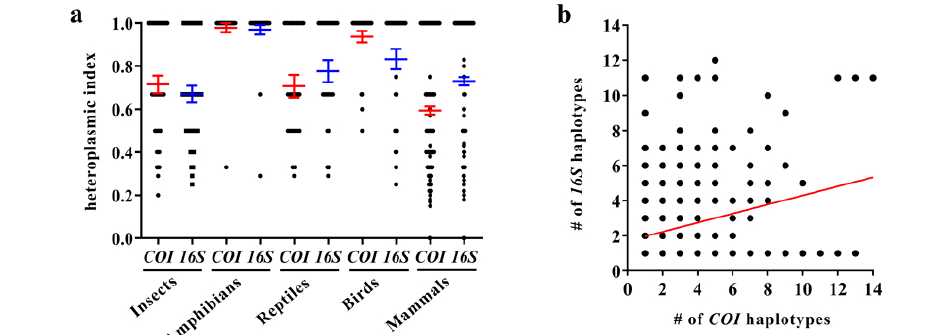
Figure 8. Heteroplasmic conditions in mitochondrial COI and 16S markers. COI and 16S are sequenced directly using PCR primers or after TA cloning, from which bacterial colonies are picked up in line with one colony per 50bp DNA unless the same sequence is captured twice. Heteroplasmy then is monitored either by the chance to obtain identical sequence (“heteroplasmic index” in a) or by the copy number of haplotypes generated (b). (b) Correlation between the copy numbers of COI and 16S barcodes for each individual specimen. Spearman's correlation coefficient rho = 0.18 (p <